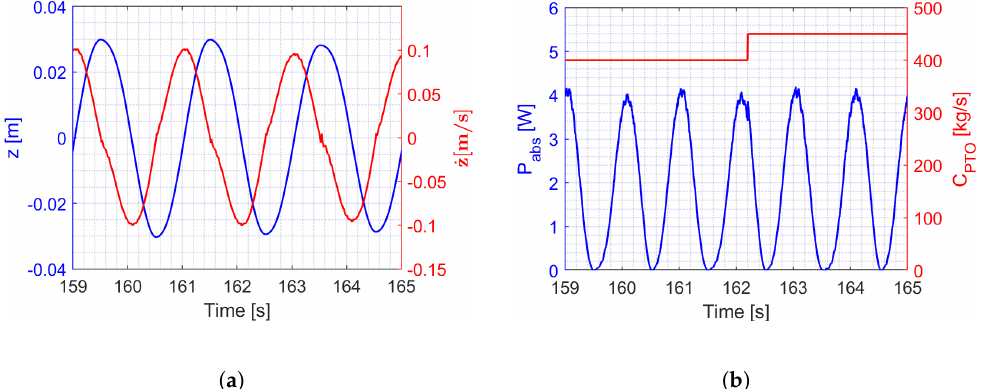
Figure 19. Resistive control test (Test_100): ( a ) z and ˙ z time series; ( b ) P abs and C PTO time